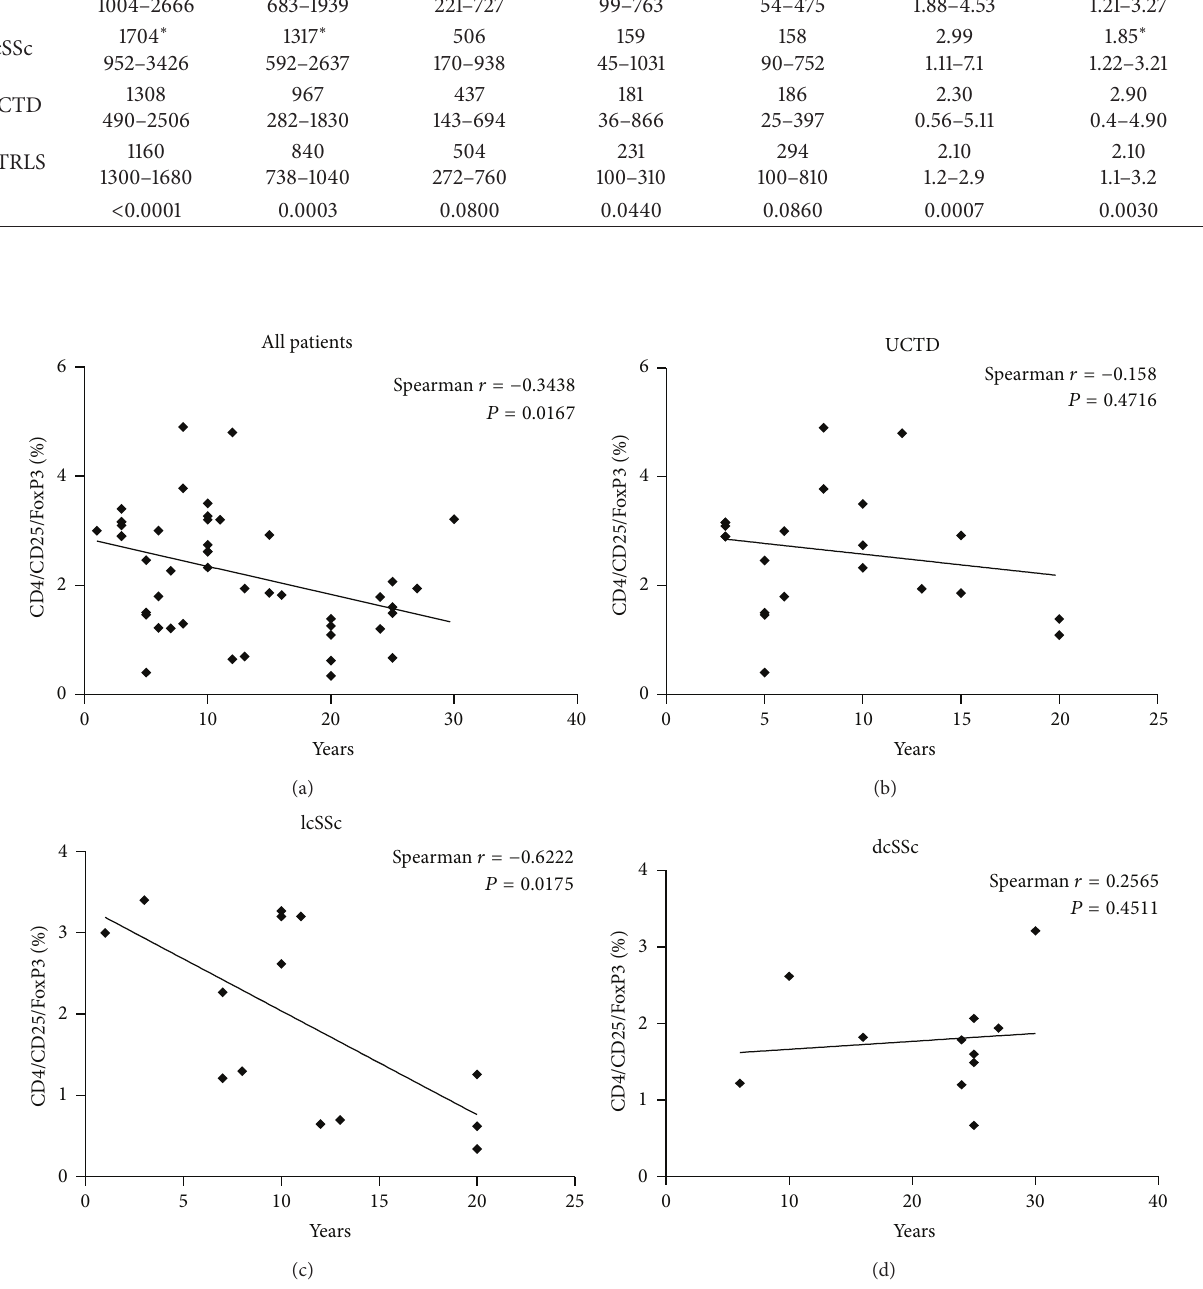
Figure 3: Correlation of T reg cell levels and disease duration in all patients (a), patients with UCTD (b), patients with SSc, limited (c), or diffuse (d)